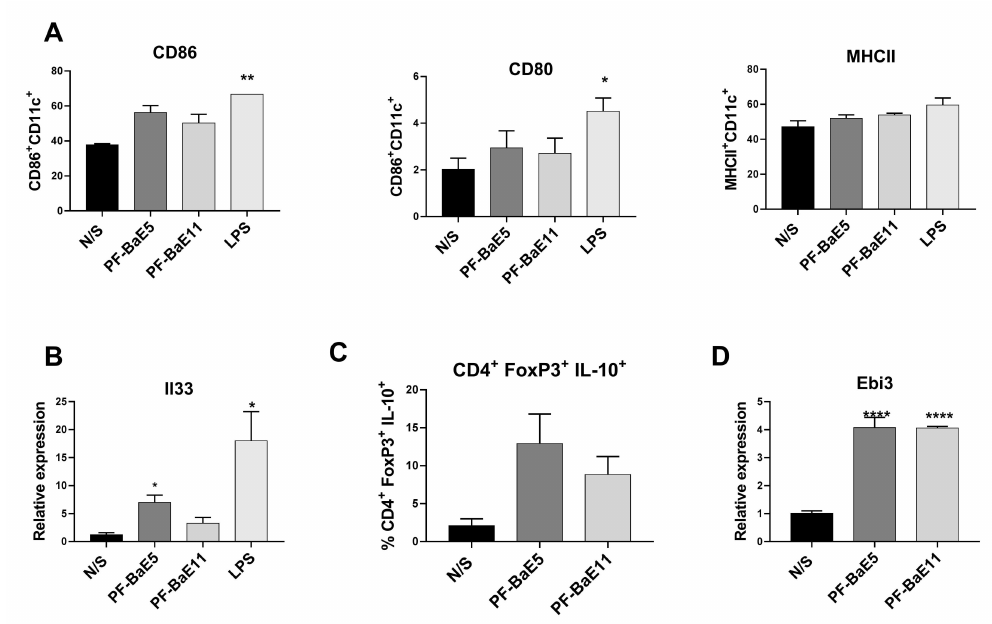
Figure 7. Ability of the strains ( A ) to activate murine BMDCs and to induce ( B ) the expression of Il33 in BMDC, ( C ) the induction of IL-10 producing CD4 + FoxP3 + T cells and ( D ) the gene expression of Ebi3 in CD4 + T cells. Data represent means ± SEM of 3 independent experiments. * refers to the comparison of bacteria-treated cells versus unstimulated cells (N / S); * p < 0.05, ** p < 0.01, **** p <